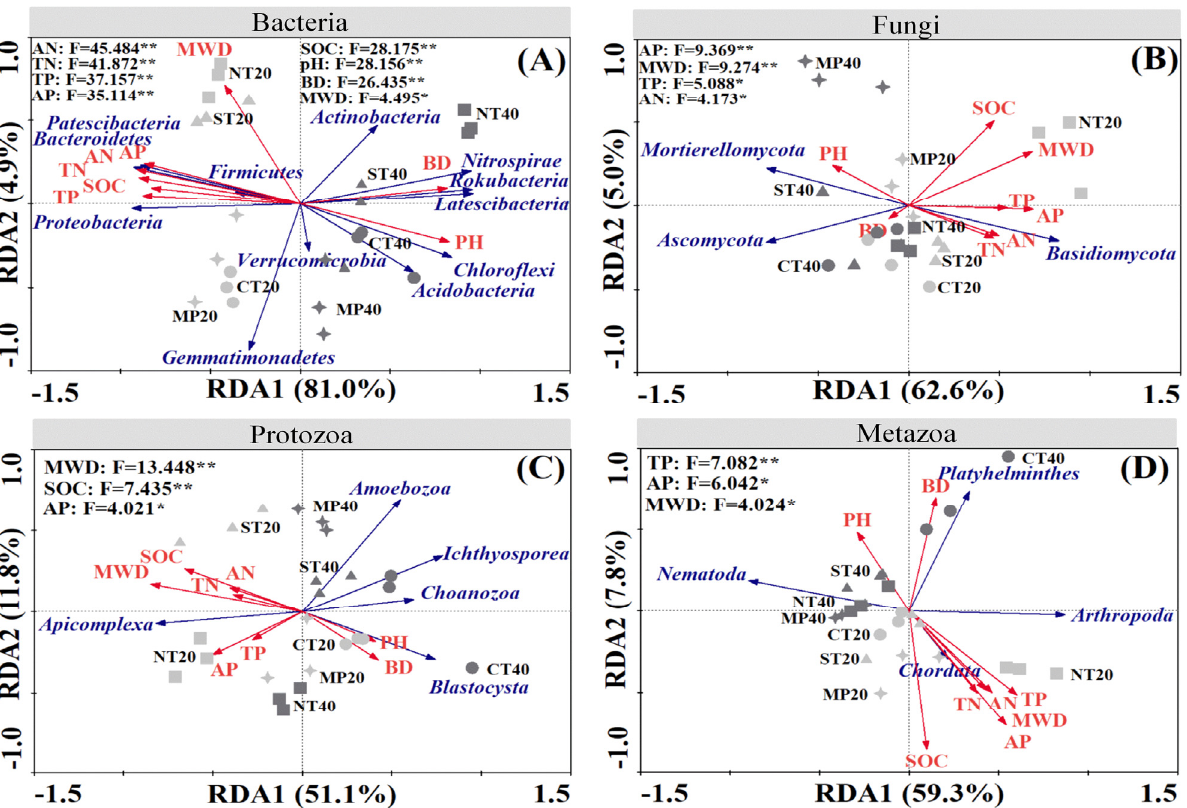
Figure 7. Ordination plots of the results from the redundancy analysis (RDA) to identify the relationships between microbial (bacteria and fungi) and faunal (protozoa and metazoa) taxa (blue arrows) and soil properties (red arrows) at the phylum level. ‘( A )’: the relationship between soil bacterial taxa and soil properties; ‘( B )’: the relationship between soil fungal taxa and soil properties; ‘( C )’: the relationship between soil protozoan taxa and soil properties; ‘( D )’: the relationship between